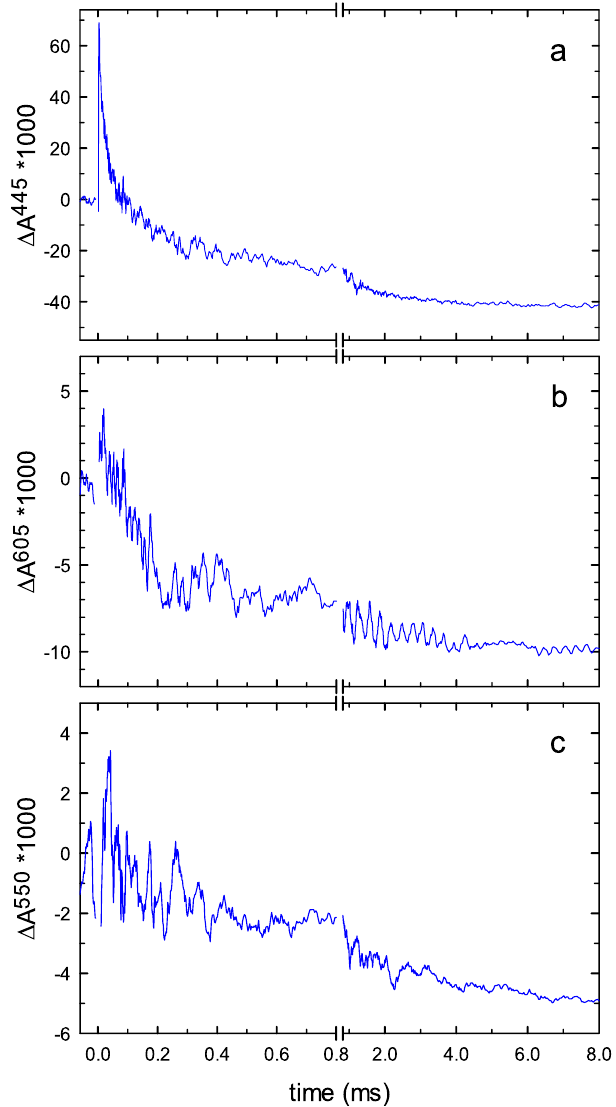
Figure 5. Reaction of membrane fragments with O 2 . The experiment is the same as that shown in Fig. 3. Absorbance changes were monitored at 445 nm ( a ) 605 nm ( b ) and 550 nm ( c ) Experimental conditions after mixing: R. sphaeroides membranes ( ∼ 2 µ M Cyt c O, calculated from the reduced minus oxidized difference spectrum) in 20 mM HEPES (pH 7.5), 100 µ M EDTA and 1 mM O 2 at ∼ 22 °C. The mixing ratio was 1:1 with an oxygen-saturated buffer (20 mM HEPES pH 7.5). The traces have been scaled to 1 µ M reacting Cyt c O. A laser artifact at t = 0 has been truncated for